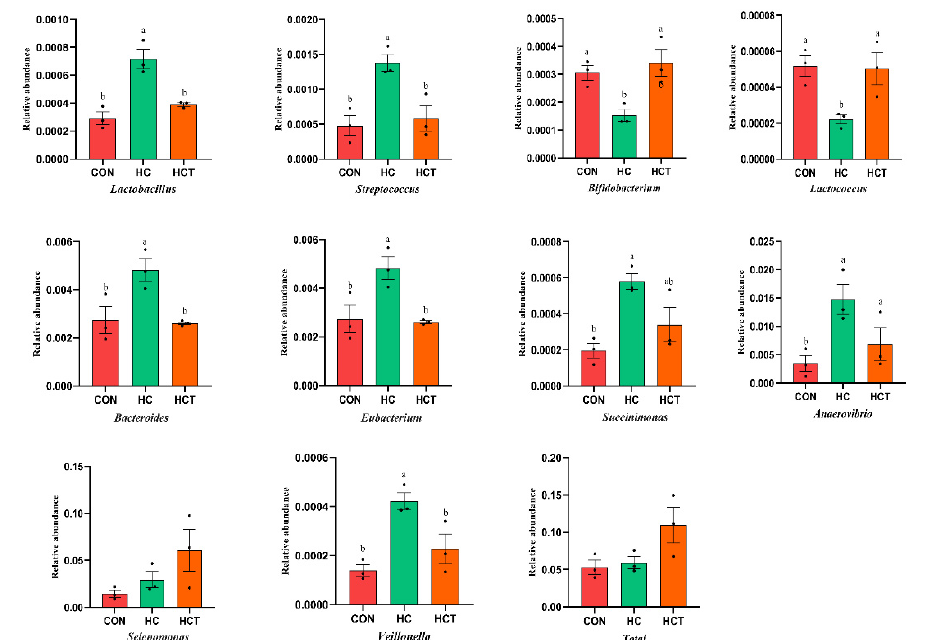
Figure 5. Effects of high-concentrate diet and thiamine supplementation treatment on the relative abundance of starch-degrading microorganism. (a–c) Means with different letters differed significantly ( p < 0.05). CON: Control diet; HC: High-concentrate diet; HCT: High-concentrate diet supplemented with thiamine.